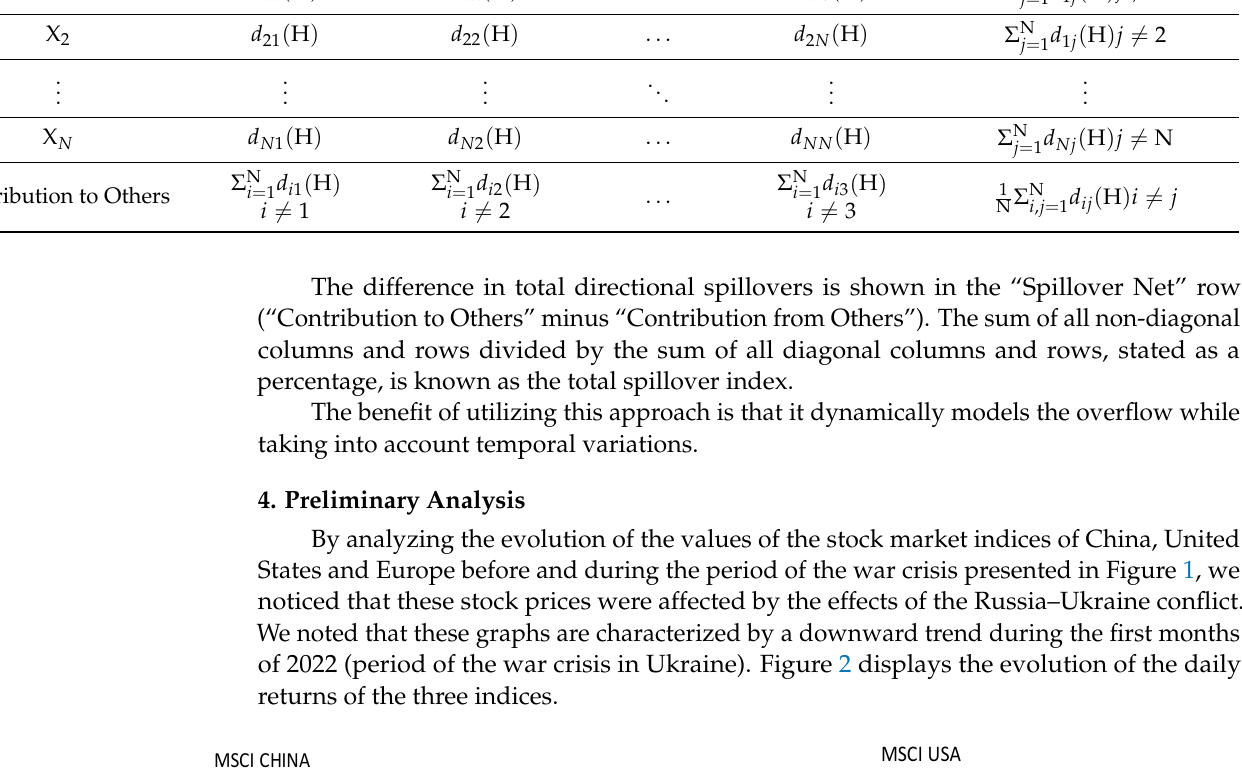
Table 1. Variance decomposition of Diebold and Yilmaz.